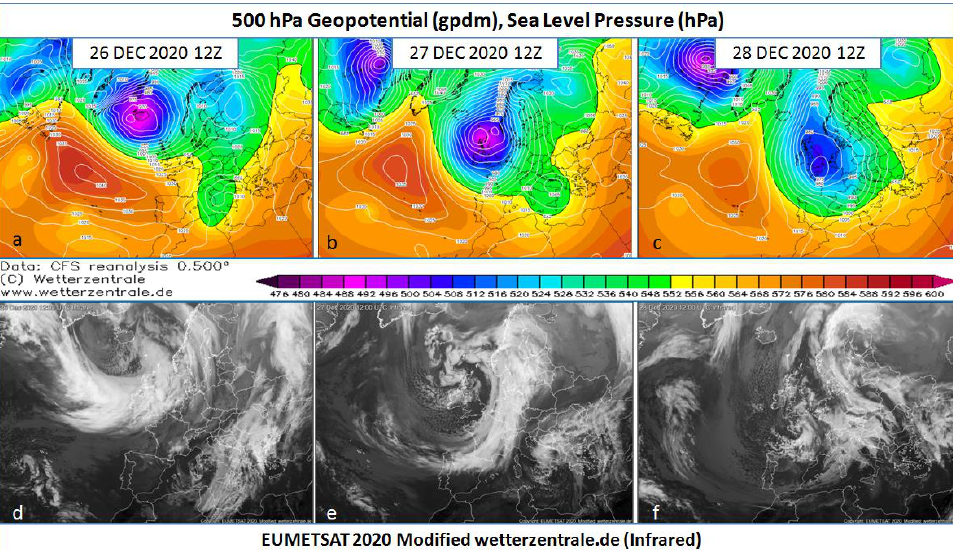
Figure 5. Meteorological maps (CFS reanalysis 0.500° by wetterzentrale.de) ( a – c ) and satellite images (EUMETSAT 2020) ( d – f ) reconstructing the three-day evolution (( a , e) , 26 December; ( b , d) , 27 December; ( c , f ), 28 December) of the storm during its transition from Iceland to the Mediterranean Sea. Maps downloaded by www.wetterzentrale.de, accessed on 6 September 2021. Meteorological map and satellite images from 26 December 2020-12:00 UTC (Figure 5a,d) show the low pressure centered south of Iceland, with a barometric minimum of 965 hPa in the inner part and a 500 hPa geopotential height less than 4850 m over Iceland. Satellite image relative to 27 December 2020-12:00UTC (Figure 5b,e) shows the low pressure centered over Scotland, with a barometric minimum of 958 hPa at the center and a 500 hPa geopotential height equal to 4900 m. These values are representative of an intense mid latitude cyclonic